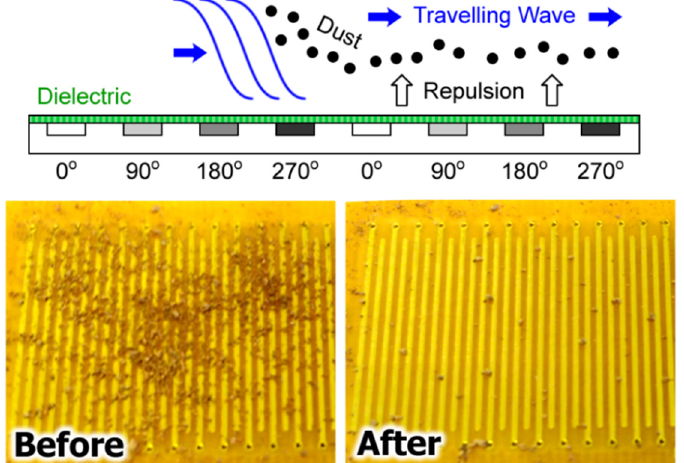
Figure 1. (top) Illustration of the electric curtain using four sequentially phase shifted signals at the same frequency applied to successive electrodes in an array. (bottom) Experimental results showing the initial and final dust distribution after the application of a 600 V, 50 Hz signal.